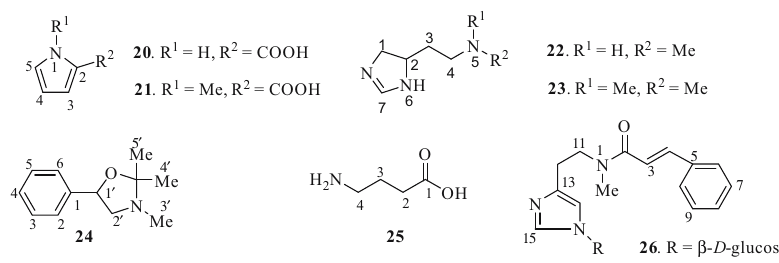
Figure 3: Structures of alkaloids from Casimiroa .